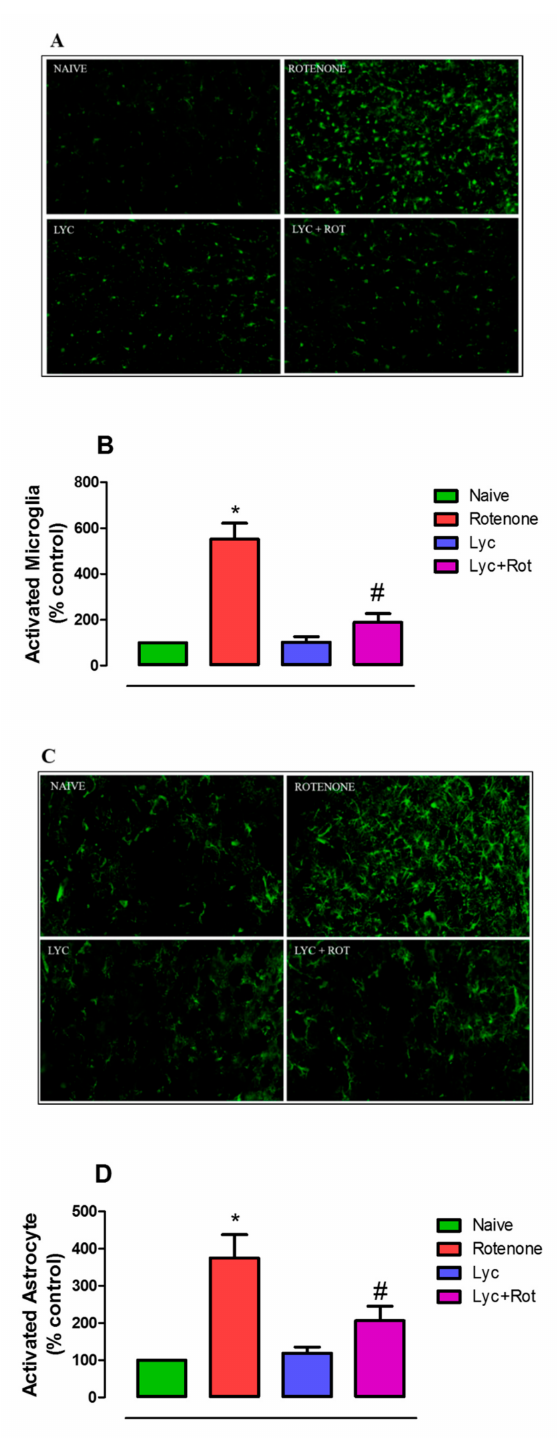
Figure 5. E ff ect of Lyc on rotenone-induced microglia and astrocyte activation. Immunofluorescent staining of brain tissues with Iba-1 ( A ) and GFAP ( C ) of experimental animals. Picture shows 20 µ m thick sections of striatum between di ff erent groups. Densitometric assessment of fluorescent intensity was performed to quantify microglia ( B ) and astrocyte ( D ) activation using Image J. Rotenone administration caused profound increase in Iba-1 positive microglia and GFAP positive astrocyte response. Alternatively, Lyc treatment decreased the activation of microglia and astrocyte, as evinced by a decrease in Iba-1 and GFAP positive cells. Values are expressed as mean ± SEM. * p < 0.05 compared to control, # p < 0.05 compared to the rotenone-treated